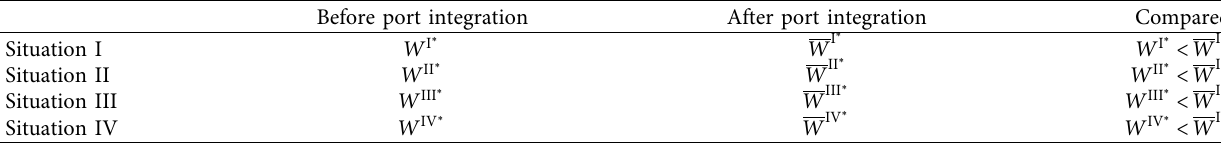
Table 2: Social welfare balance before and after port integration.